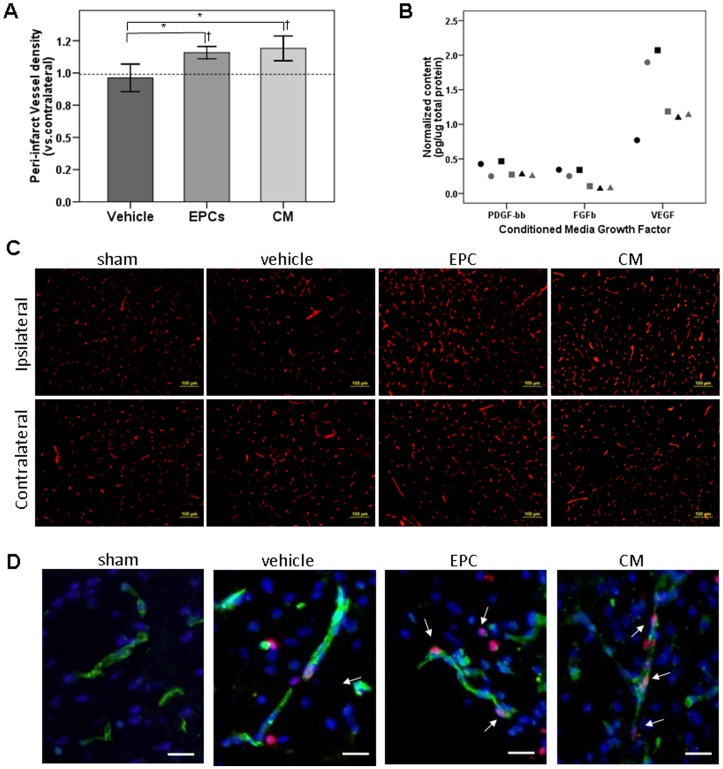
Peri-infarct angiogenesis after treatment.Bar graph representing vessel density (mean±SD vs. contralateral) in peri-infarct regions of ischemic animals treated with vehicle (n = 10), EPCs (n = 9) or CM (n = 6); dashed line shows reference (mean) for sham (n = 4) animals (A); * indicates p<0.05 vs. vehicle and † indicates p<0.05 vs. sham. Graph showing CM content of PDGF-bb, FGF-b and VEGF in six different cultures of EPCs represented as black or grey circles, squares or triangles (B). Representative micrographs of lectin immunofluorescence; bars represent 100 µm (C). Representative micrographs of CD-31 (green) and BrdU (red) staining merged with DAPI showing proliferating endothelial cells (arrows) in peri-infarct areas; bars represent 20 µm (D).